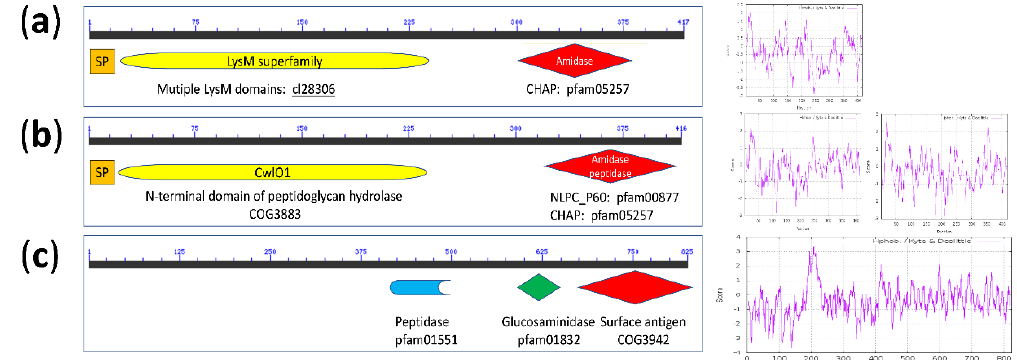
Figure 4. Domain layout and hydrophobicity profiles of peptidoglycan D , L -endopeptidases. Domain